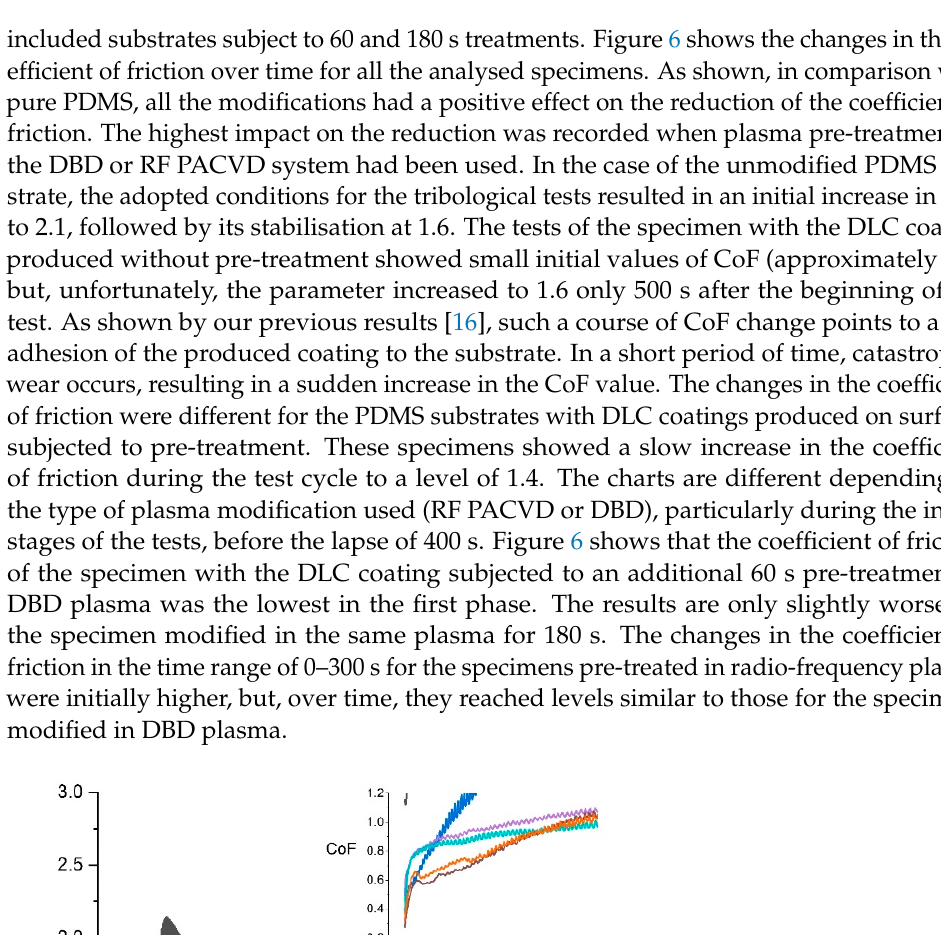
Figure 7. Analysis of wear rates achieved for substrates used in the tribological tests. 3.6. Wear Analysis After the tribological tests, the specimens were subject to surface tests, where the wear marks were assessed using optical microscopy. The friction between the ceramic ball and the unmodified PDMS substrate produced a large amount of wear products, pushed outside the wear area (Figure 8a). Our earlier tests on the application of DLC coatings for modifying polymer substrates showed that their wear rates were variable over time [17].